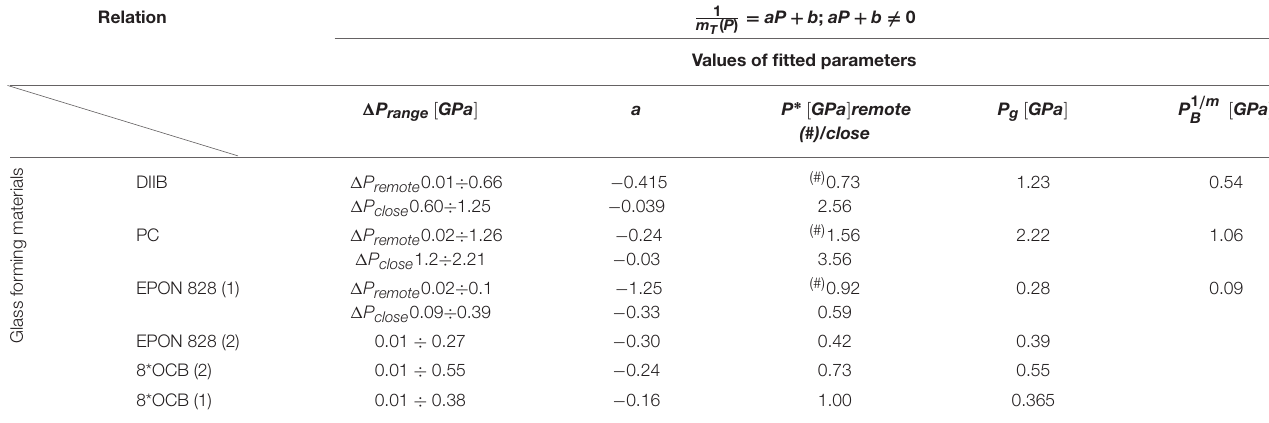
TABLE 1 | Results of the linear regression fit for the reciprocal of apparent fragility m T ( P ) : see Equations (12, 13).